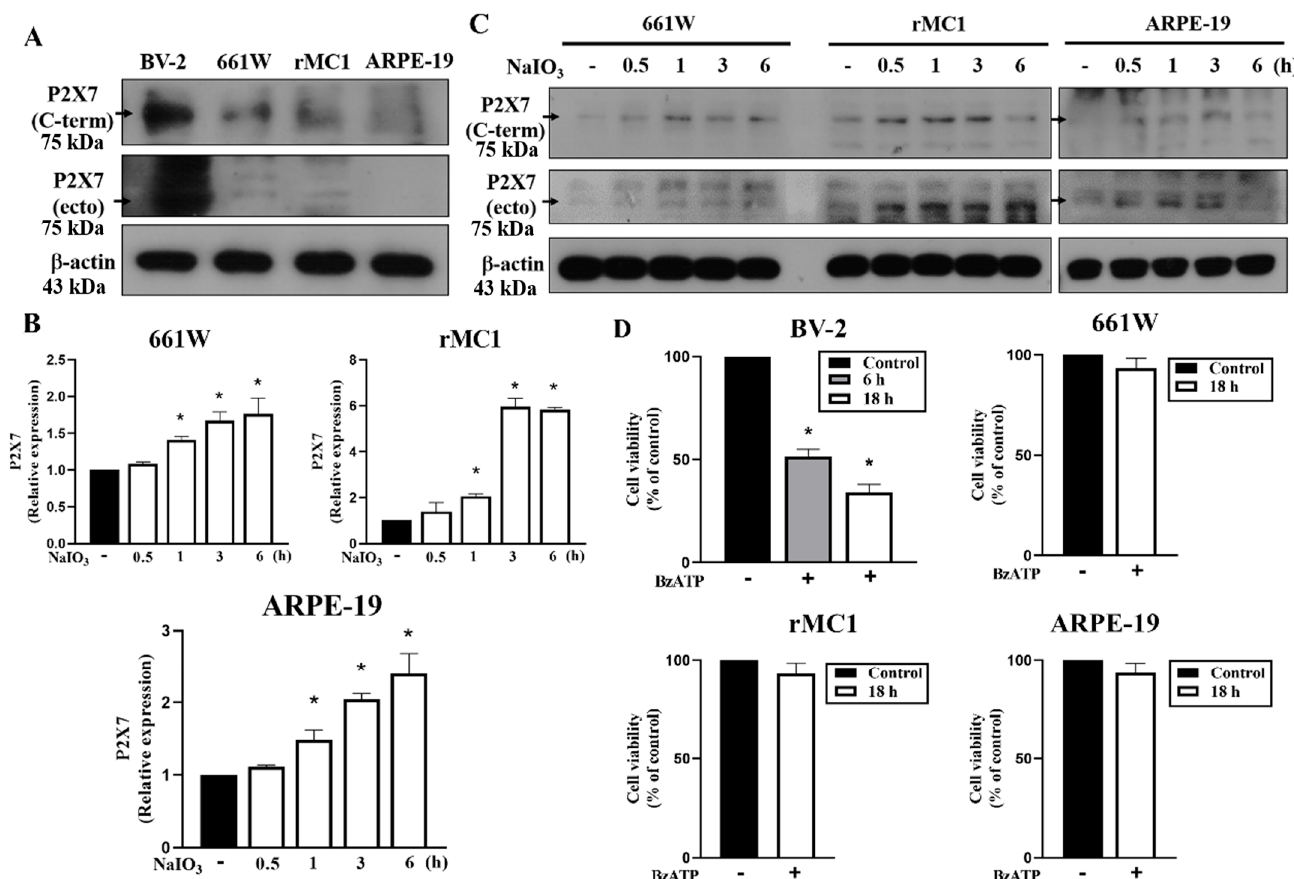
Figure 7. Comparison of P2X7 expression and effects of BzATP on cell viability in BV-2, 661W, ARPE-19 and rMC1 cells. ( A ) P2X7 protein level in each cell type was determined by immunoblot- ting. ( B , C ) Cells were treated with NaIO 3 (30 mM) for the indicated times. P2X7 mRNA level was determined by real-time PCR ( B ) and P2X7 protein was determined by immunoblotting ( C ). ( D ) Each cell type was treated with vehicle or BzATP (200 μ M) for 6 or 18 h. Cell death was determined by Annexin V/PI staining with FACS. * p < 0.05, indicating the increased P2X7 gene expression by NaIO 3 ( B ) and the cell death caused by BzATP ( D ).